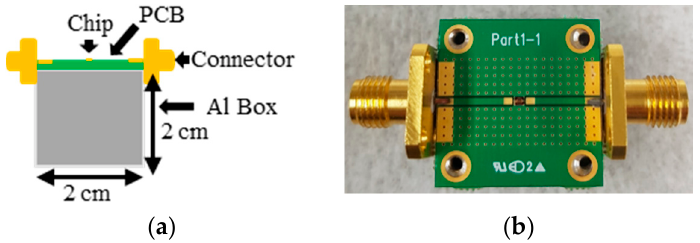
Figure 4. A printed circuit board (PCB) and ground are shown in ( a ) cross-section view, ( b ) and a top section with a design chip.